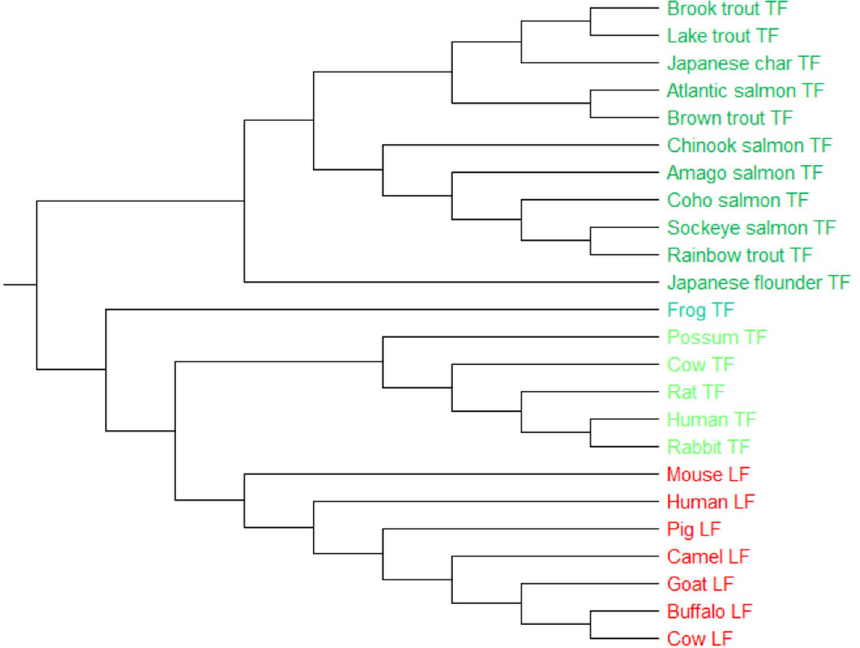
Figure 9. The phylogenetic tree of 24 sequences of transferrins protein constructed by our method (UPGMA).